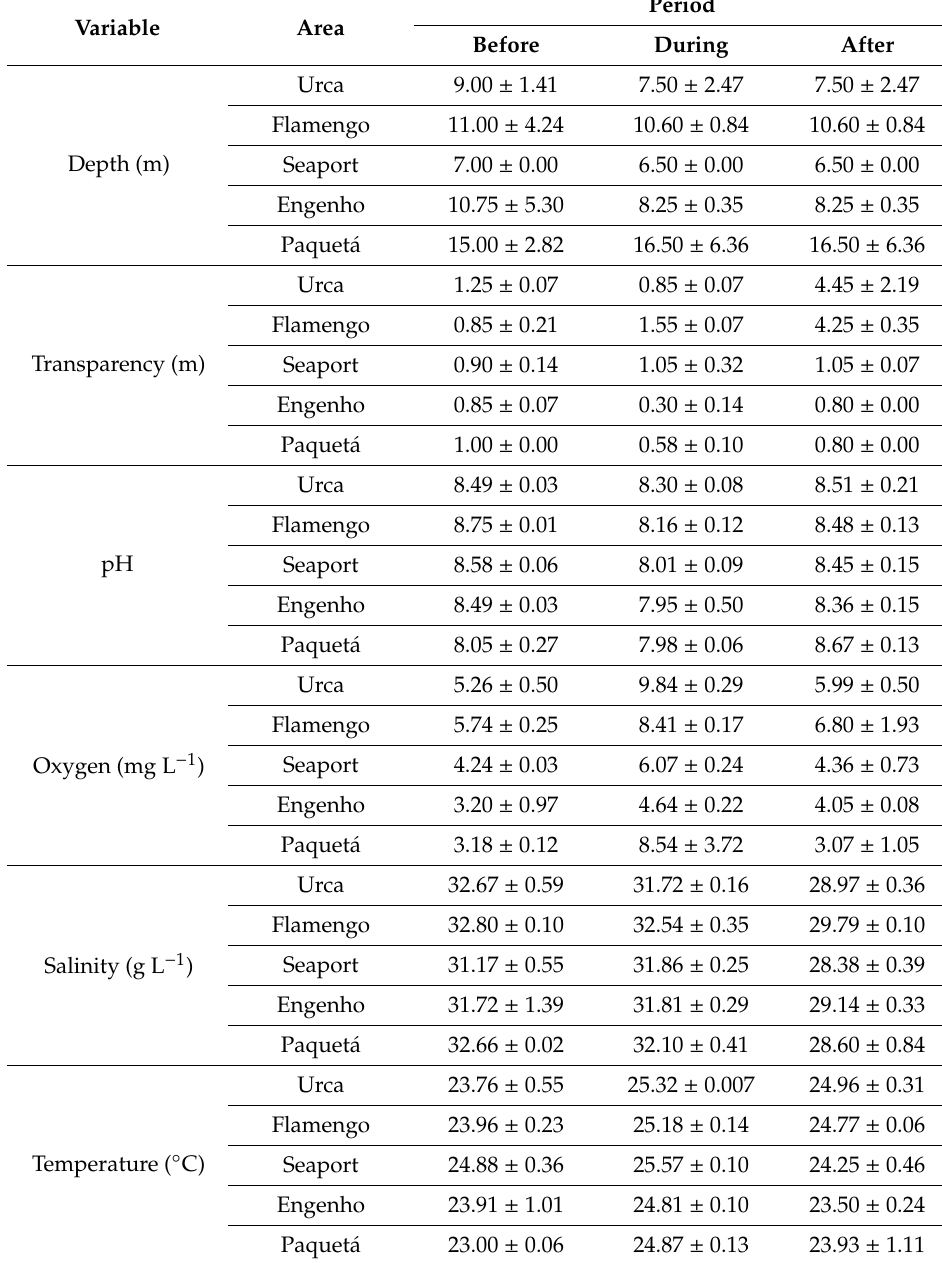
Table 1. Abioticvariablesofeachsamplingpoint, before, duringandafterRiodeJaneirosedimentdredging.